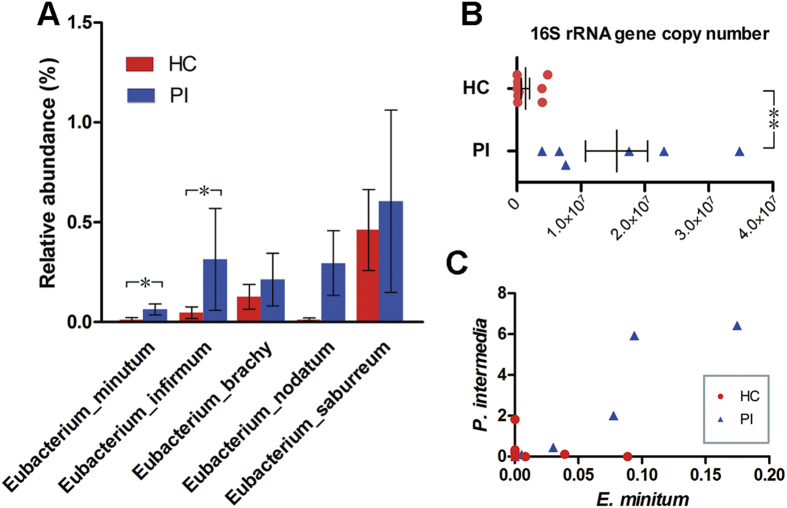
Members of the genus Eubacterium in healthy implant (HC) and peri-implantitis (PI) sites.(A) The relative abundances of Eubacterium species were compared. Bars represent the means ± SEMs of the relative abundances of detected species. *P < 0.05 by the Wilcoxon rank-sum test. (B) Total abundances, measured via real-time qPCR, of the Eubacterium brachy subgroup (including E. brachy, E. infirmum, E. nodatum, and E. tardum). **P < 0.01 by Wilcoxon rank-sum test. (C) Positive correlation between Eubacterium minutum and Prevotella intermedia.